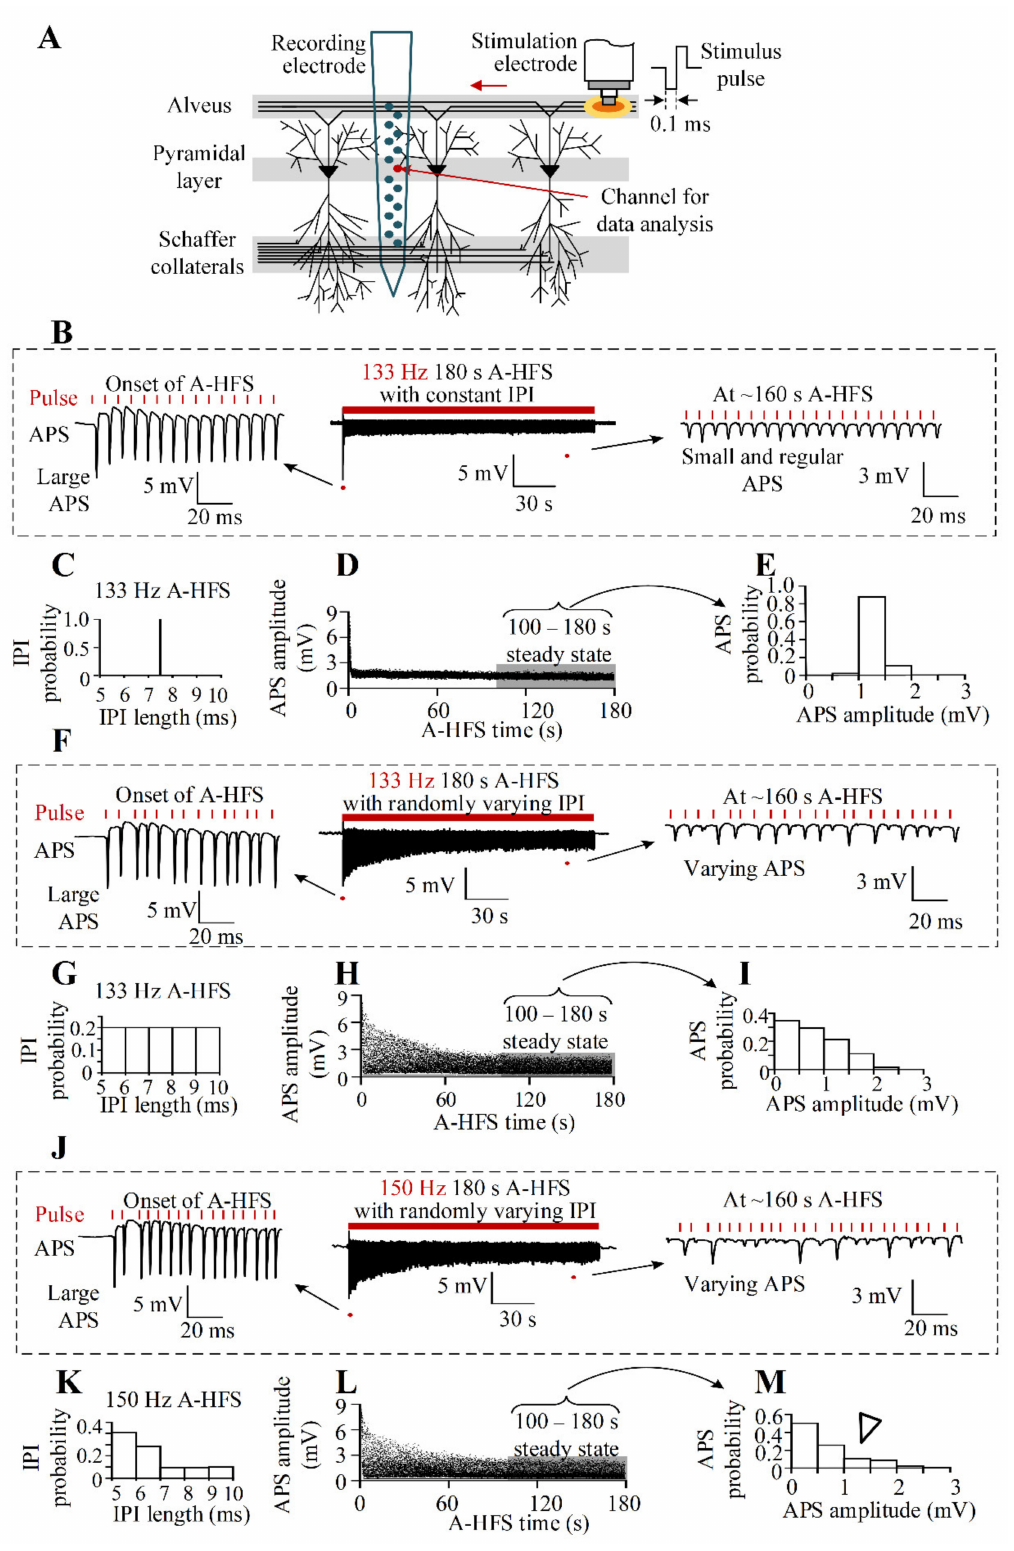
Figure 1. Different neuronal responses induced by 3-min A-HFS sequences with constant IPI 7.5 ms or with randomly vary- ing IPI in a range of 5–10 ms but with different distributions. ( A ) Schematic diagram of the locations of recording